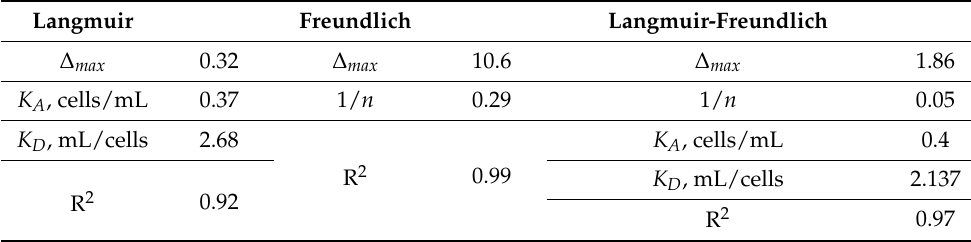
Table 2. Isotherm models parameter values of HER2/neu-based QCM chip. Langmuir Freundlich